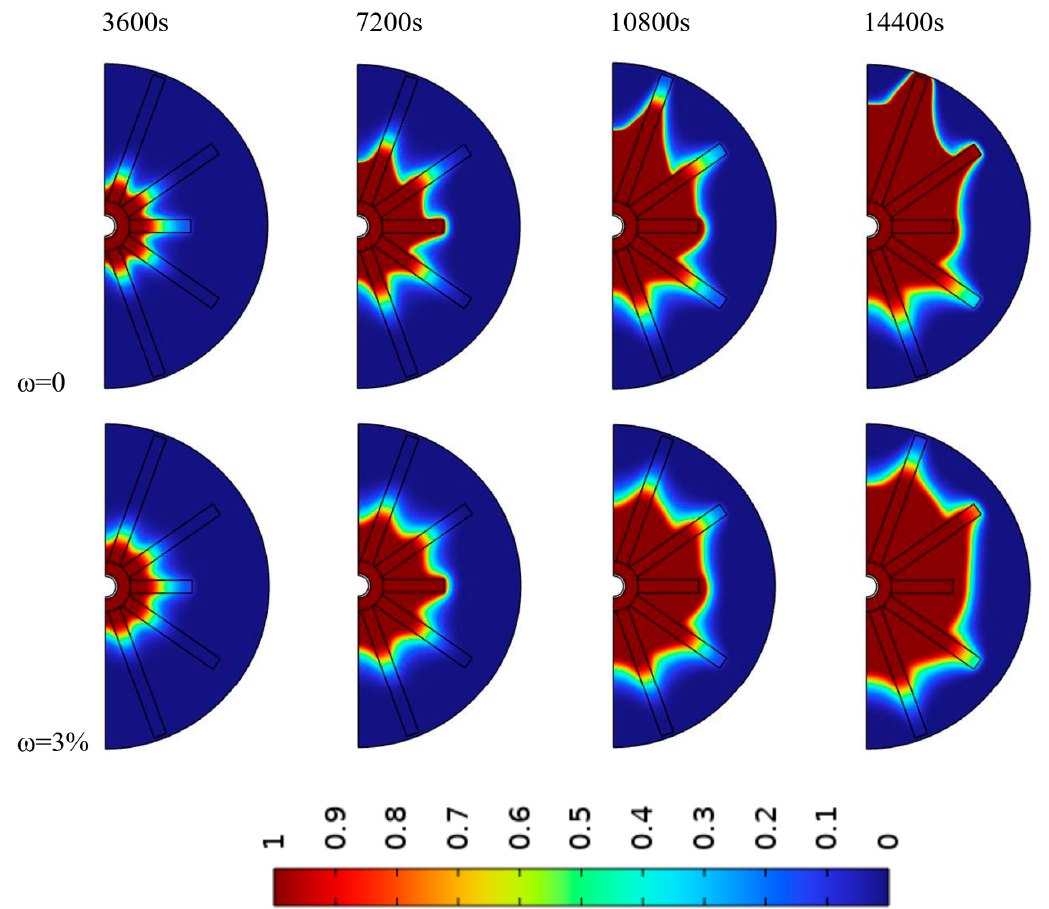
Figure 10. The MVF maps at different time steps for two cases of ω = 0 and ω = 3% wt when ε = 0.95 and δ = 35°.